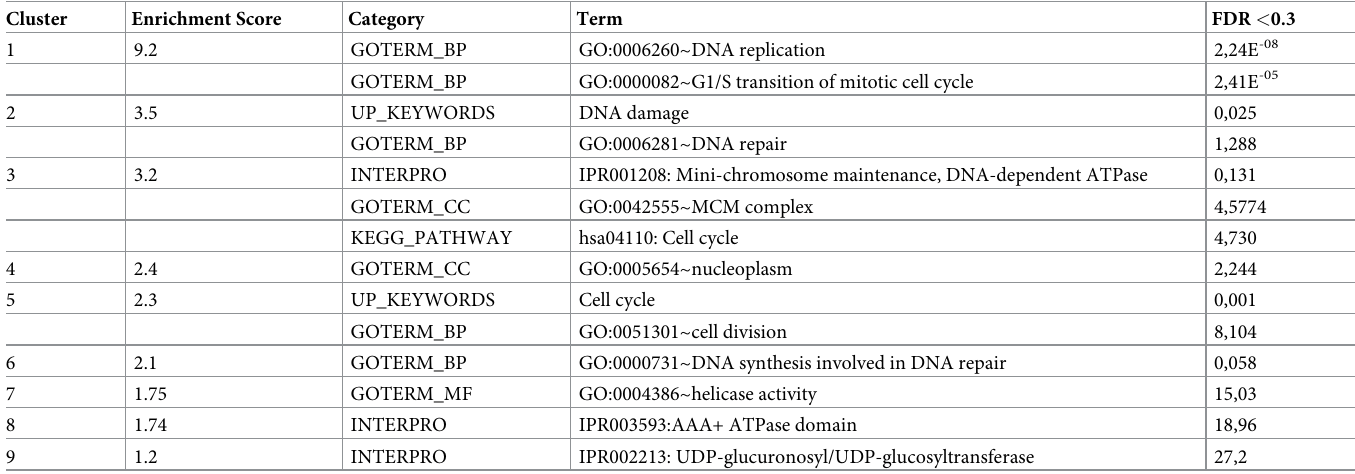
Table 2. DAVID functional annotation clustering of upregulated genes in cEDS patients’ skin fibroblasts. Cluster Enrichment